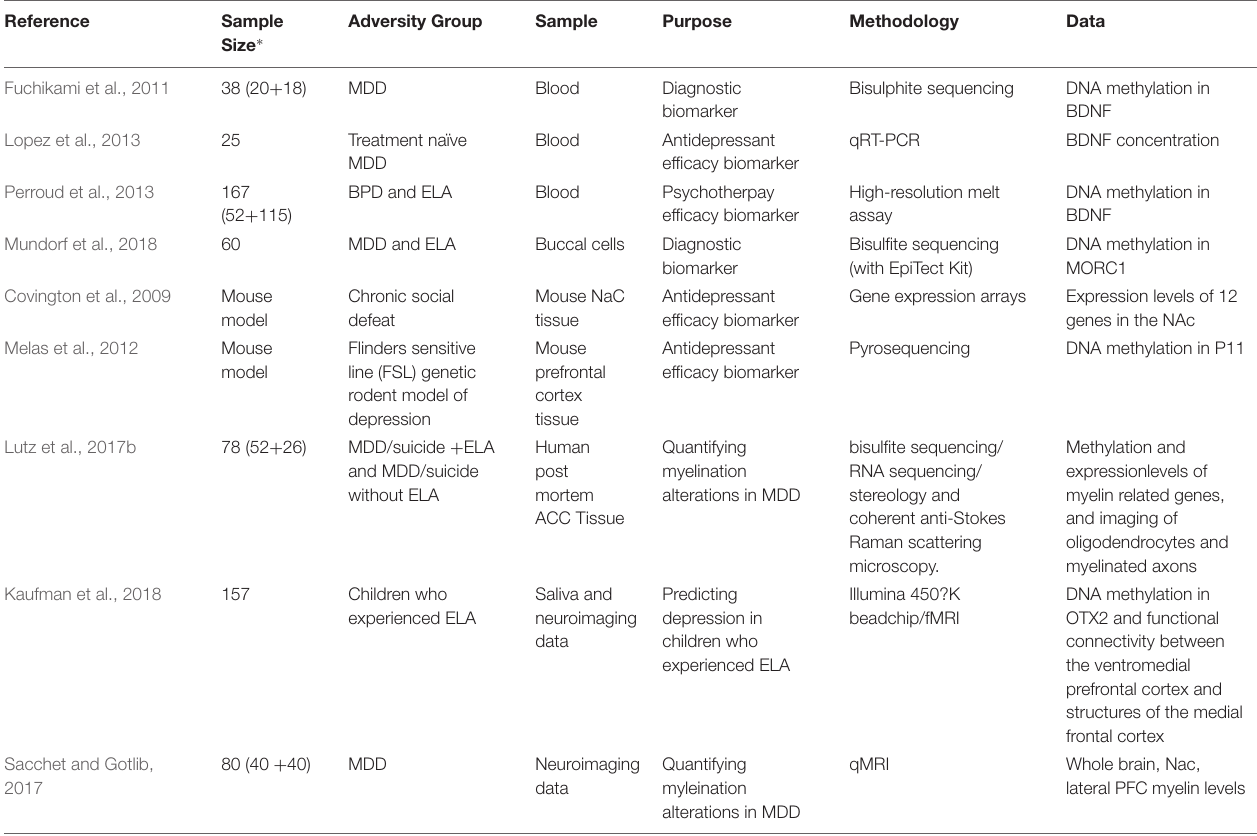
TABLE 1 | Summary of studies investigating clinical applications of ELA and MDD research involving- or related to – DNA methylation in ELA and